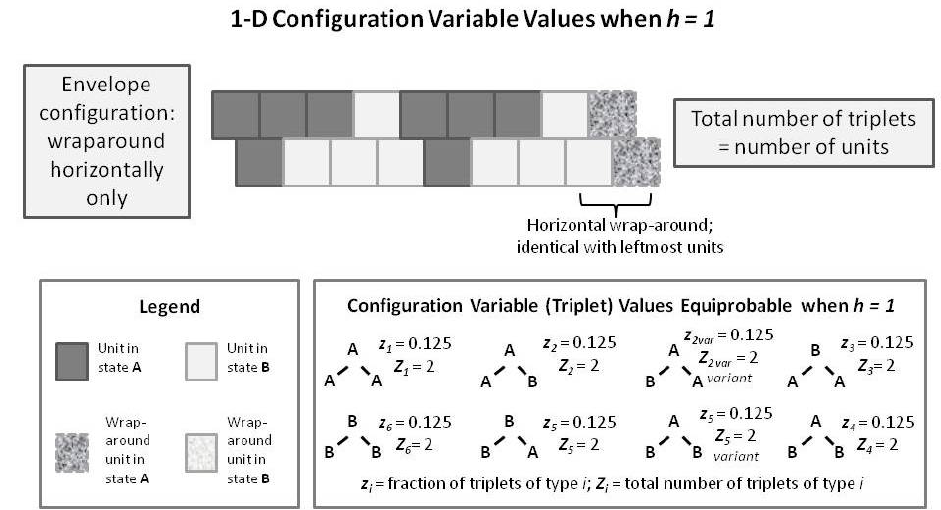
Figure 7. A 1-D CVM configuration (single zigzag chain), together with both the total numbers and fractional amounts for the configuration variables z i . Notice that there is a horizontal wraparound for the computation of the configuration variables. The total number of triplets is equal to the total number of units in the